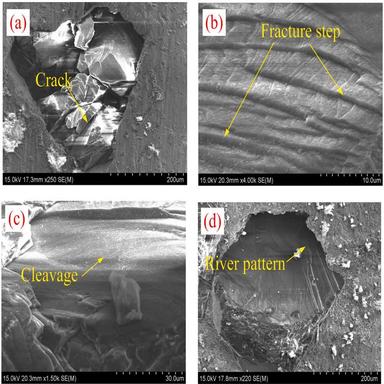
Fracture morphology of stone processed by DGs.